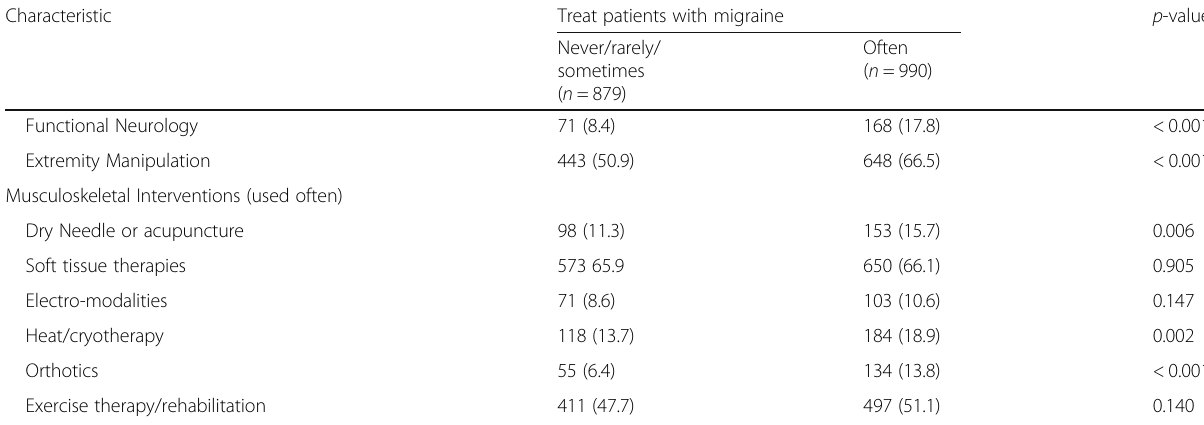
Table 3 Distribution of clinical management characteristics across frequency of practitioner treating patients with migraine (Continued) Characteristic